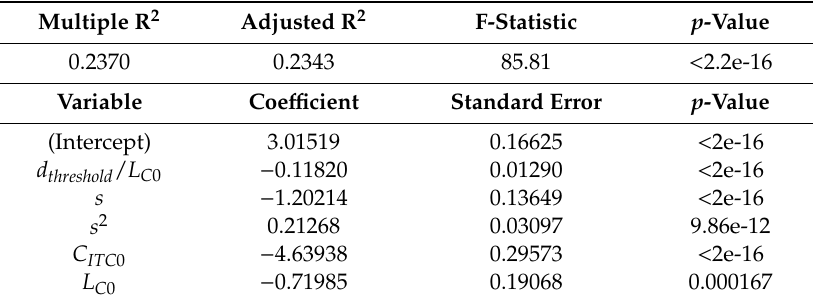
Table 5. Regression analysis of log-transformed maximum